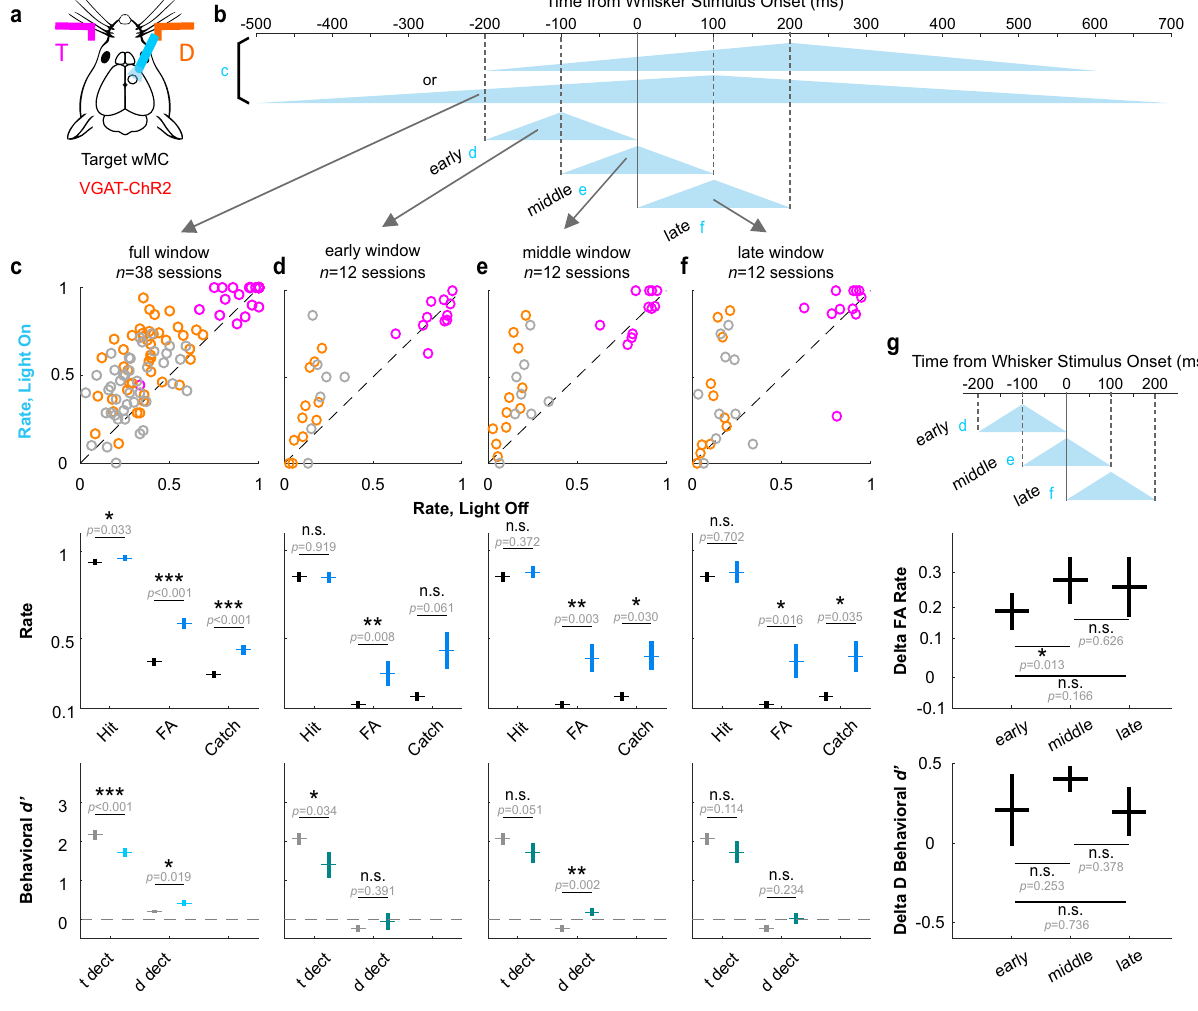
respectively. g Statistical comparison for the behavioral results in [ d – f ]. “ Delta FA Rate ” is calculated as light_on false alarm rate - light_off false alarm rate from the middle row of [ d – f ]. “ Delta D Behavioral d ’ ” is calculated as light_on behavioral d ’ - light_offbehavioral d ’ ofdistractordetectionfromthebottomrowof[ d – f ].Sample sizes are shown in the fi gure. Statistical comparisons are from two-tailed paired t-tests, without correction for multiple comparisons. Data are represented as